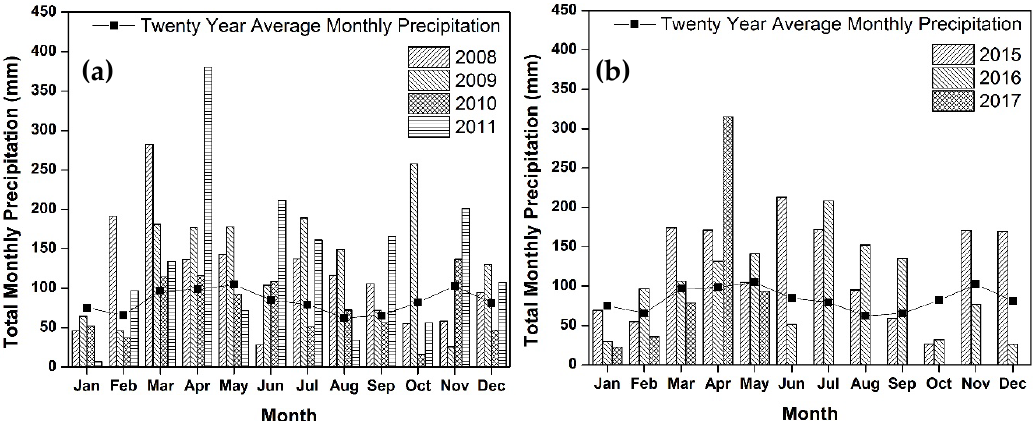
Figure 2. Mean monthly precipitation received at the paired watershed site during calibration ( a ) and treatment ( b ) periods.